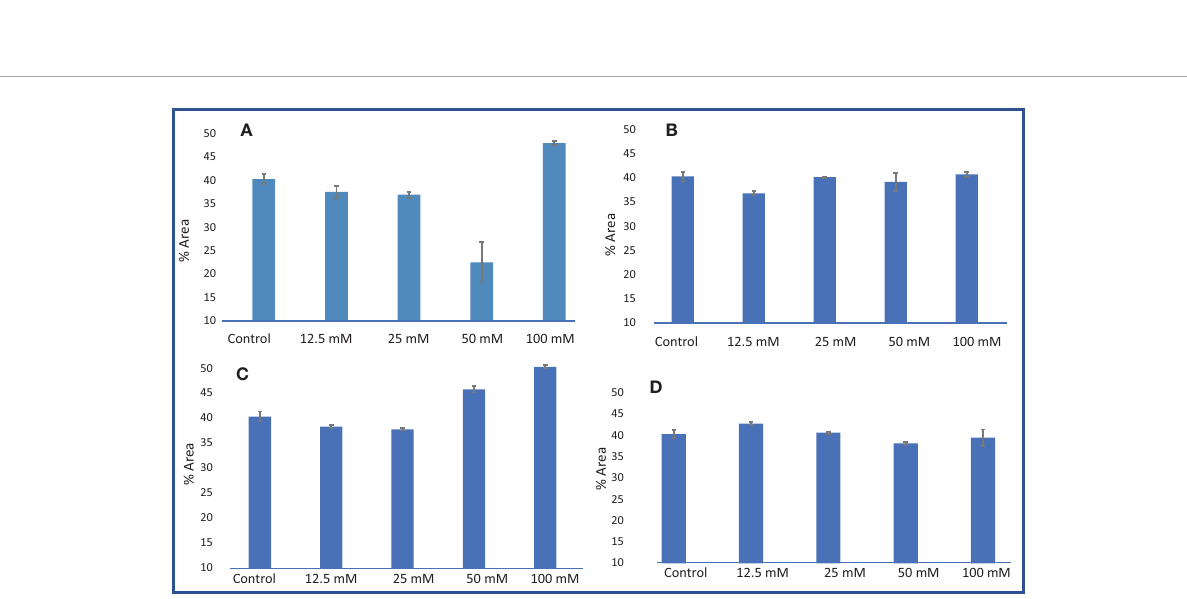
FIGURE 10 Limonene % area obtained from GC – MS analysis in an M. longifolia essential oil sample under salt stress condition. (A) Different concentrations of NaCl; (B) Different concentrations of KCl; (C) Different concentrations of MgSO 4 ; and (D) Different concentrations of CaCl 2 . The data are represented as mean ± standard deviation (n =